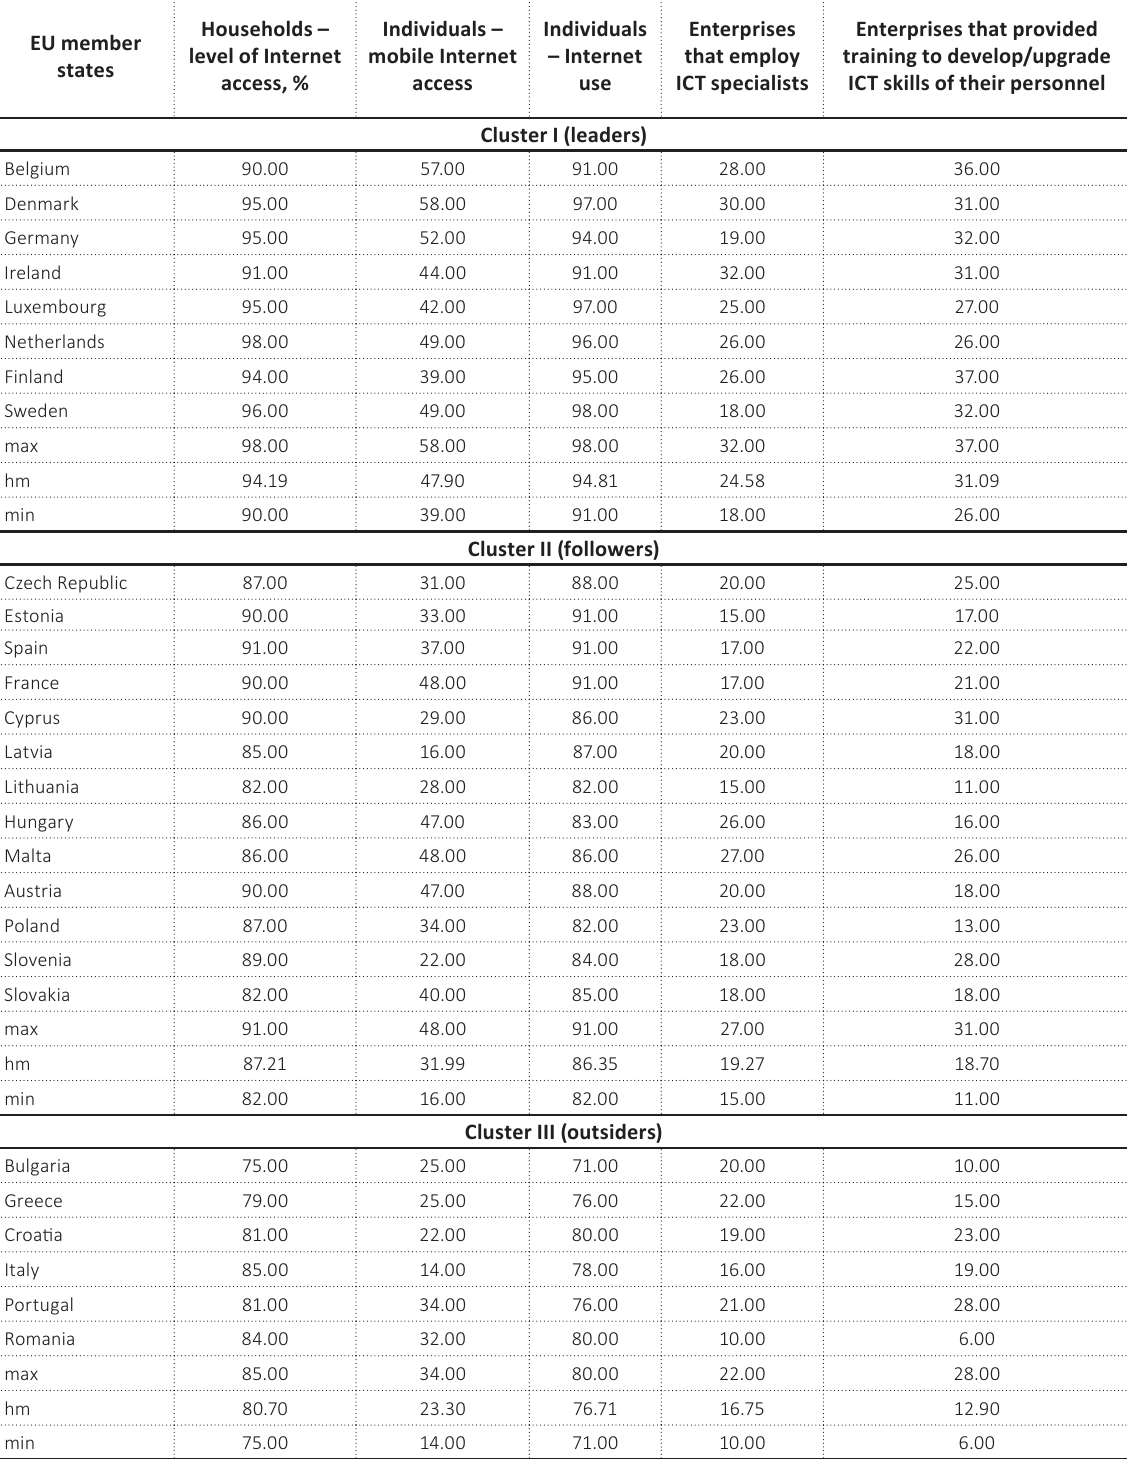
Table 2. Parameter chart to manage DE development in EU